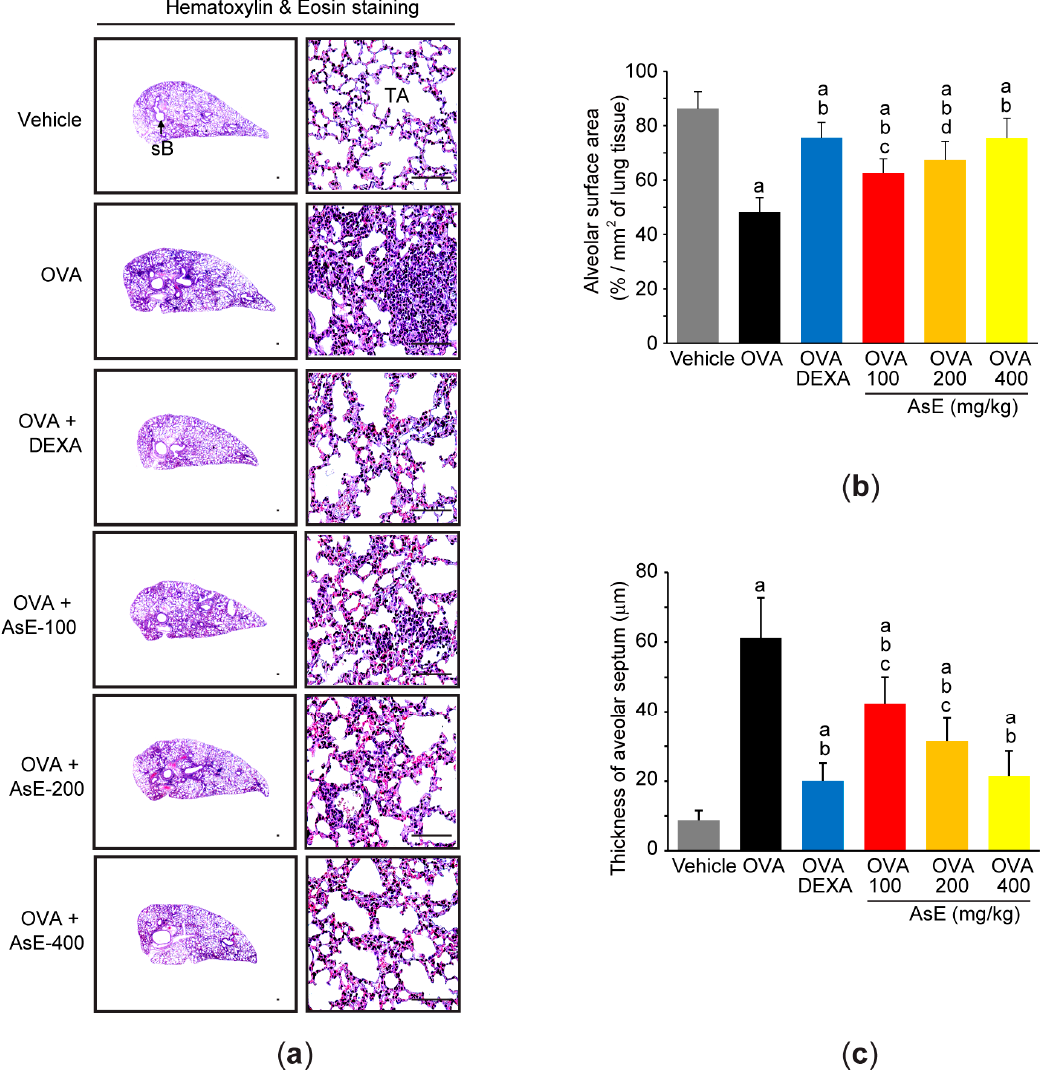
Figure 2. AsE mitigates pulmonary injury in OVA-induced allergic asthma. ( a ) Representative histological image of hematoxylin- and eosin-stained lung tissue. Scale bars indicate 200 µm. Alveolar surface area ( b ) and thickness of alveolar septum ( c ) were measured using an image analyzer. a p < 0.01 versus vehicle group; b p < 0.01 versus OVA group; c p < 0.01, d p < 0.05 versus OVA + DEXA group; sB, secondary bronchus; TA, terminal respiratory bronchiole alveoli. Table 1. Cytological analysis of bronchoalveolar lavage fluid. Experimental